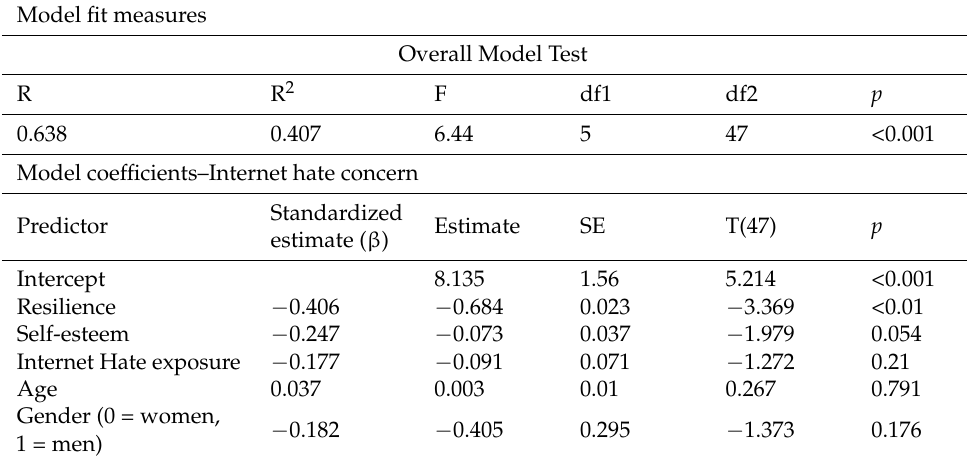
Table 2. Regression model predicting higher Internet Hate Concern in Public Figures ( n =